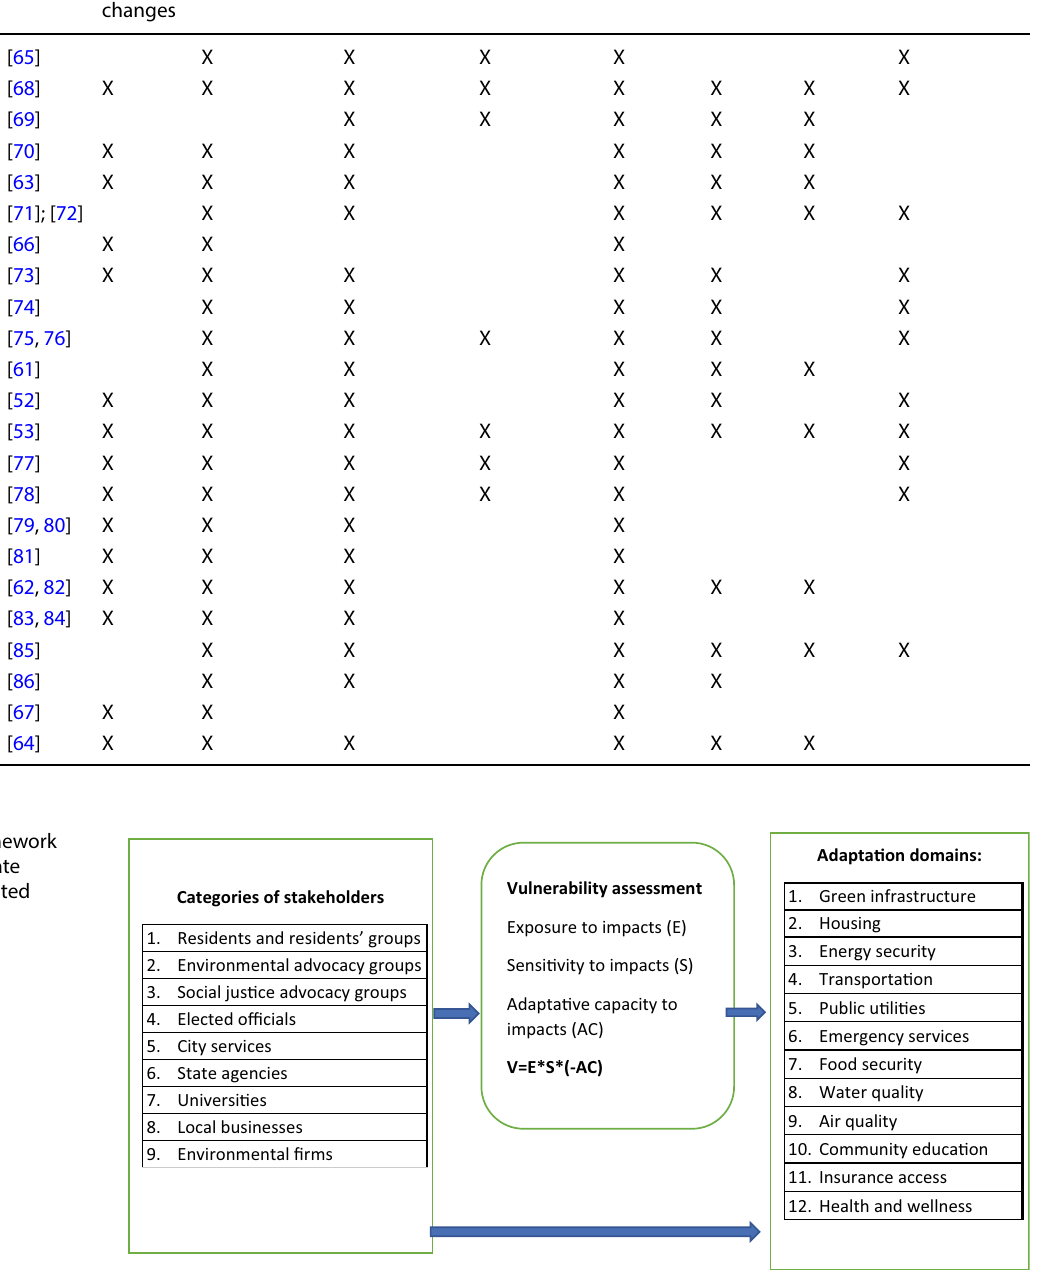
Table 1 Local climate adaptation plans examined in this study Municipality